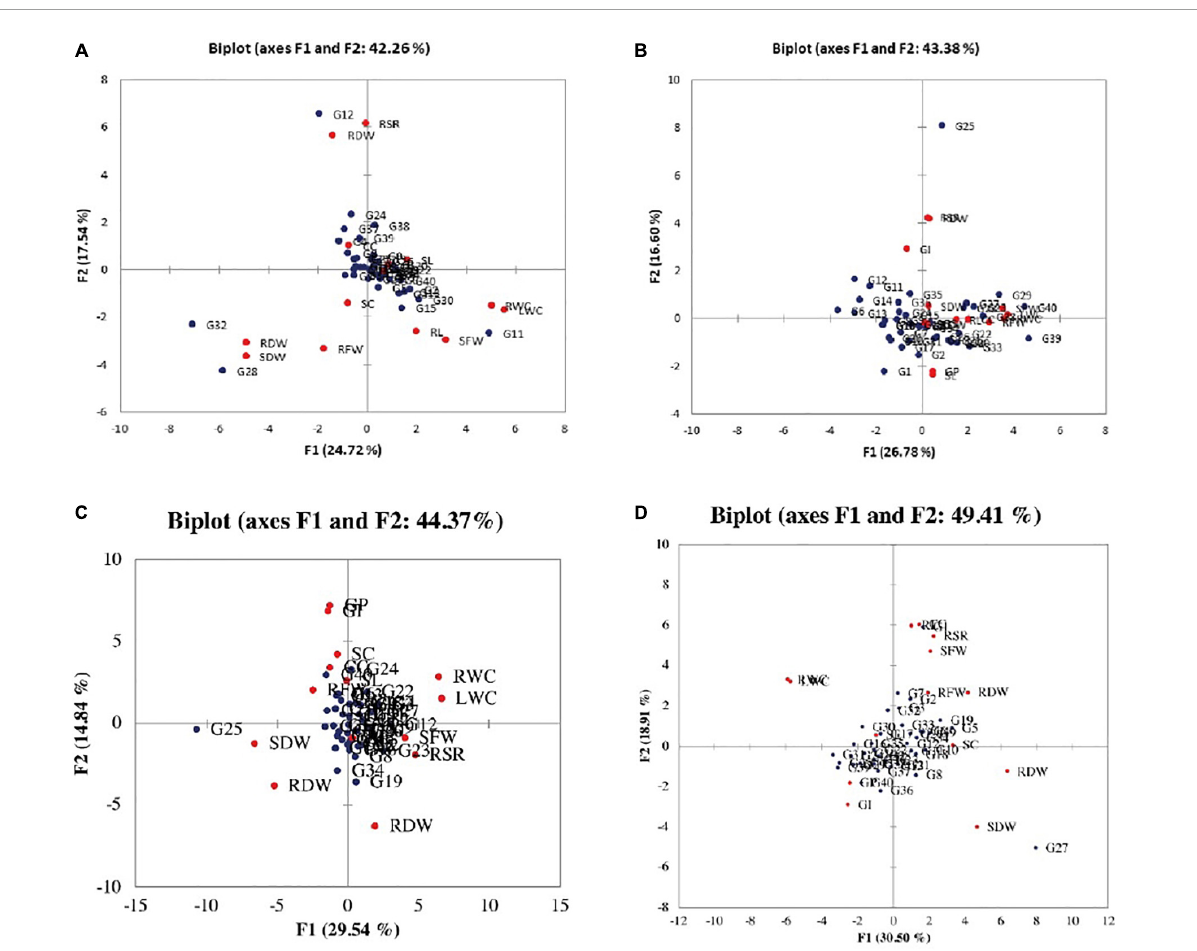
FIGURE2 Biplot between the genotypes and the studied traits under (A) normal condition, (B) salinity stress at 4 dSm − 1 , (C) salinity stress at 8 dSm − 1 , and (D) salinity stress at 12 dSm − 1 . The red circle shows traits and the blue circle shows genotypes. GP, germination percentage; GI, germination index; SC, stomatal conductance; CC, chlorophyll content; RL, root length; SL, shoot length; RFW, root fresh weight; SFW, shoot fresh weight; RDW, root dry weight; SDW, shoot dry weight; RWC, relative water content; LWC, leaf water content; RSR, root shoot ratio; RDW, relative dry